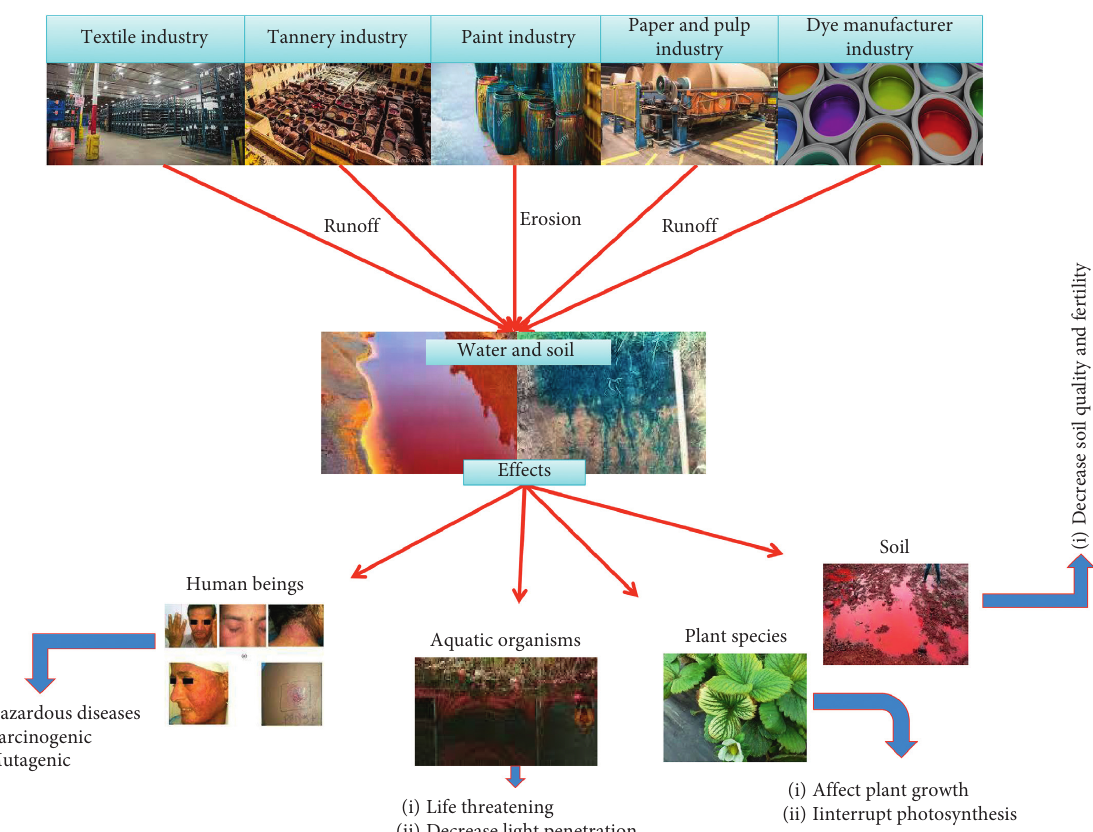
Figure 1: The hazardous effects of synthetic dyes on the environment from different industries